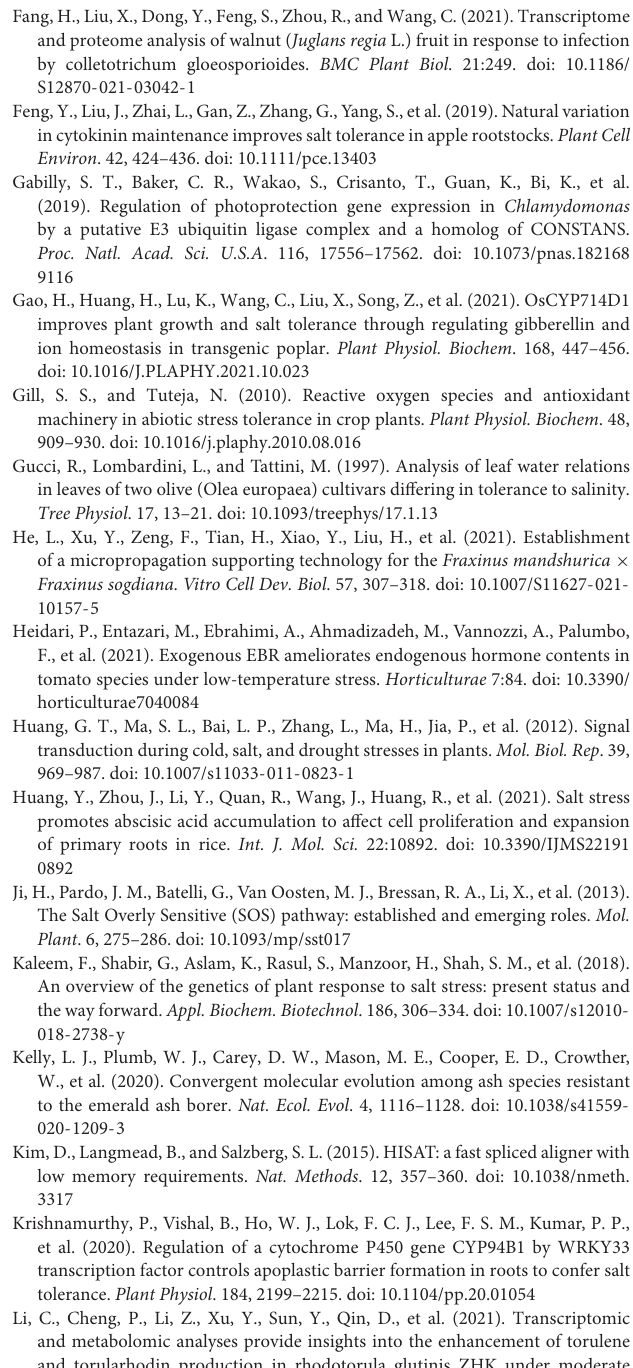
comparisons S4SR vs. S4CR, R7CR vs. S4CR, R7SR vs. S4SR, and R7SR vs. R7CR based on Z-score. The color represented the Z-score. From blue to red represented the Z-score from low to high. (B) Venn diagram showed the distribution of upregulated and downregulated DEGs among different comparisons, respectively. Supplementary Figure 4 | The Kyoto Encyclopedia of Genes and Genomes (KEGG) pathway analysis of downregulated genes in comparison R7SL vs.